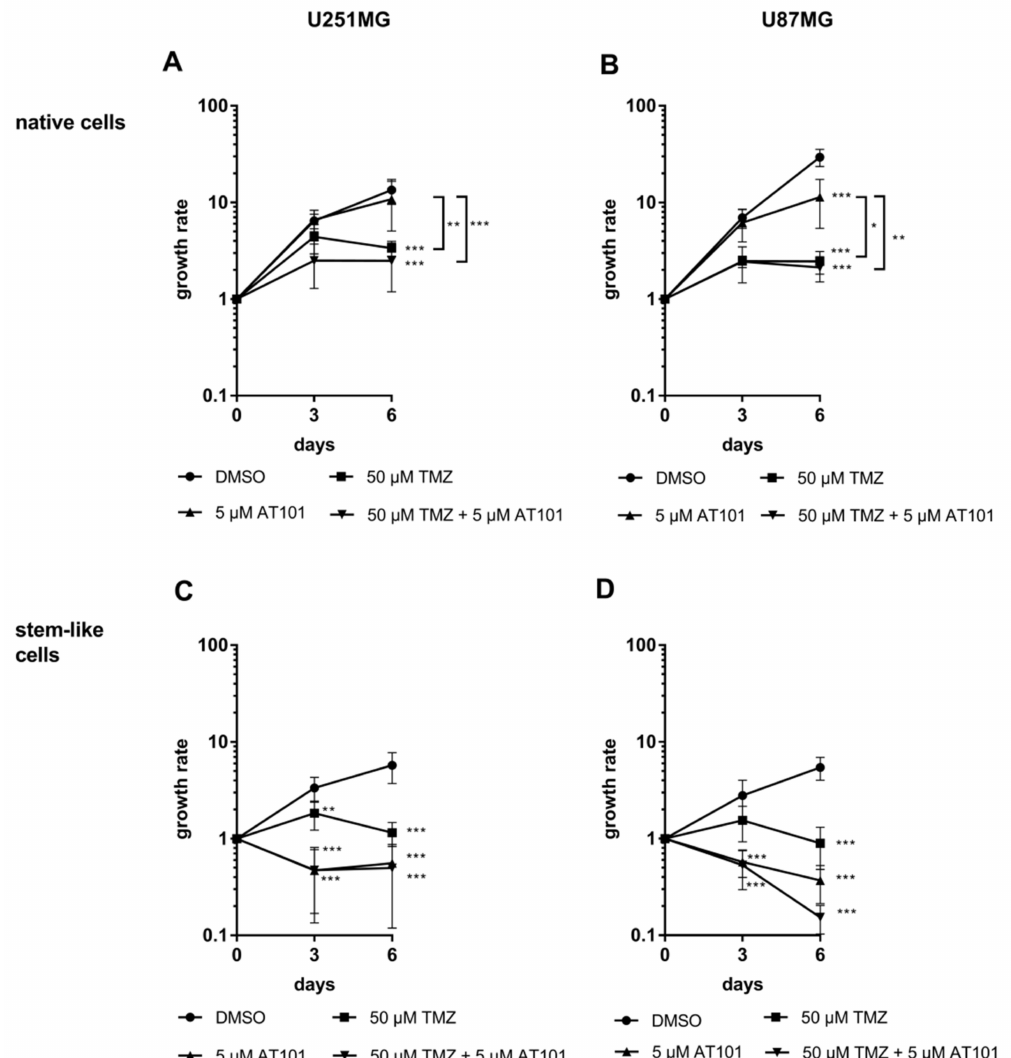
Figure 2. The anti-proliferative effects of AT101 were enhanced in stem-like U251MG and U87MG GBM cells compared to native GBM cells. Cells were stimulated with DMSO (control), temozolomide [50 µ M], AT101 [5 µ M], or temozolomide [50 µ M] and AT101 [5 µ M]. Counting of viable cells was performed at day 0, 3, and 6 of stimulation, and growth rates were calculated as the n-fold number of alive cells compared to day 0. Growth curves of native ( A ) U251MG and ( B ) U87MG cells, as well as of stem-like ( C ) U251MG and ( D ) U87MG cells are depicted. The significances between different stimulation approaches were determined with a two-way ANOVA test followed by Tukey’s multiple comparison test. Significant differences compared to the DMSO control are indicated directly next to the curves and between different stimulations on a line linking the curves (* p < 0.05; ** p < 0.01; *** p < 0.001). Error bars correspond to the standard deviation, n =